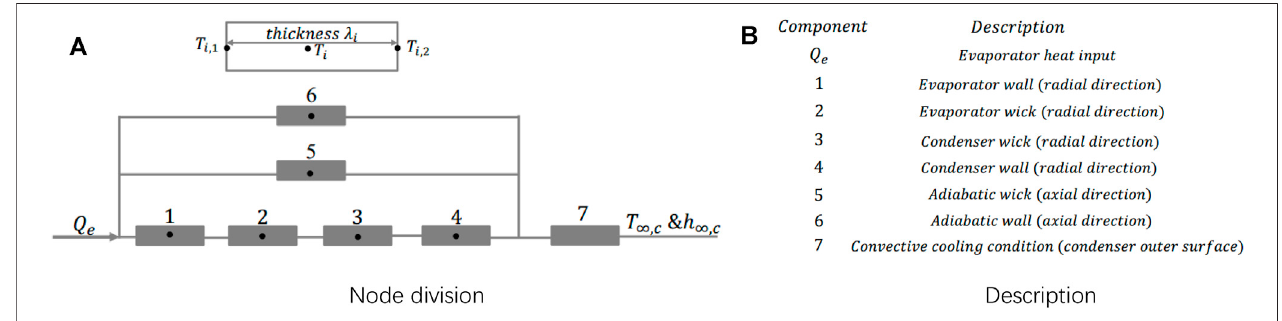
FIGURE 2 | Traditional network model for a heat